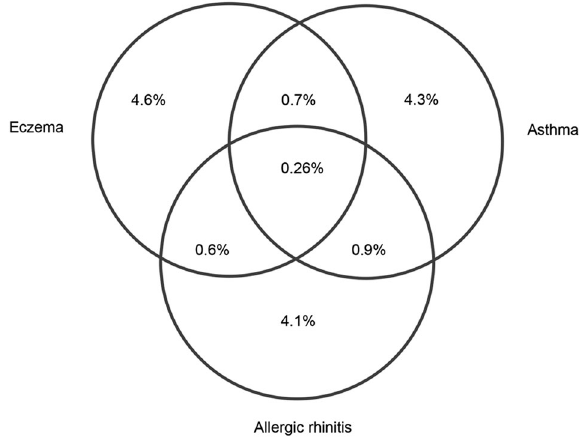
Fig. 5 Venn diagram of the overall prevalence (total population: 478,076